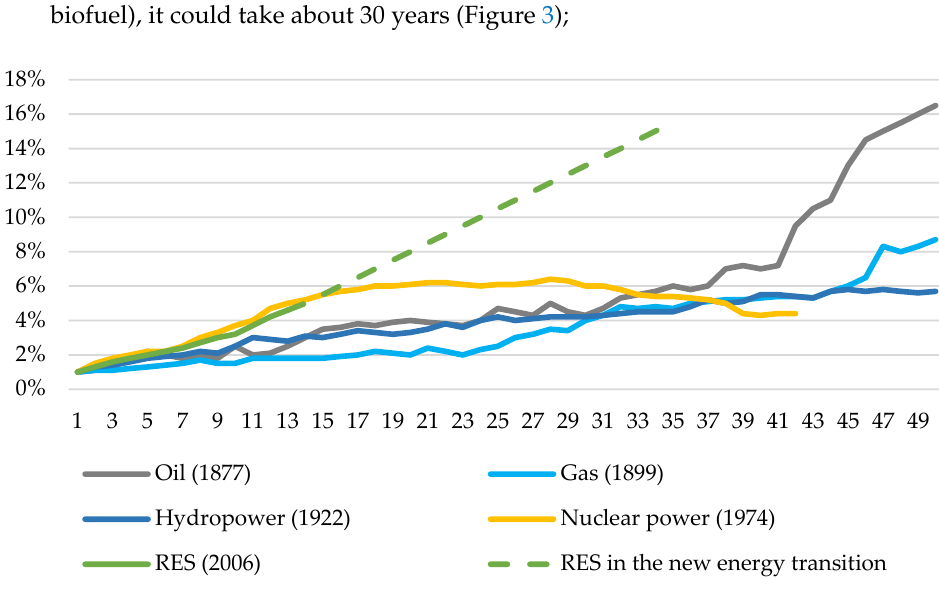
Figure 3. The speed of the shift to specific primary energy sources in different energy transitions (the first year is the year when a certain type of energy source reached 1% of the global energy mix) (based on [18]).